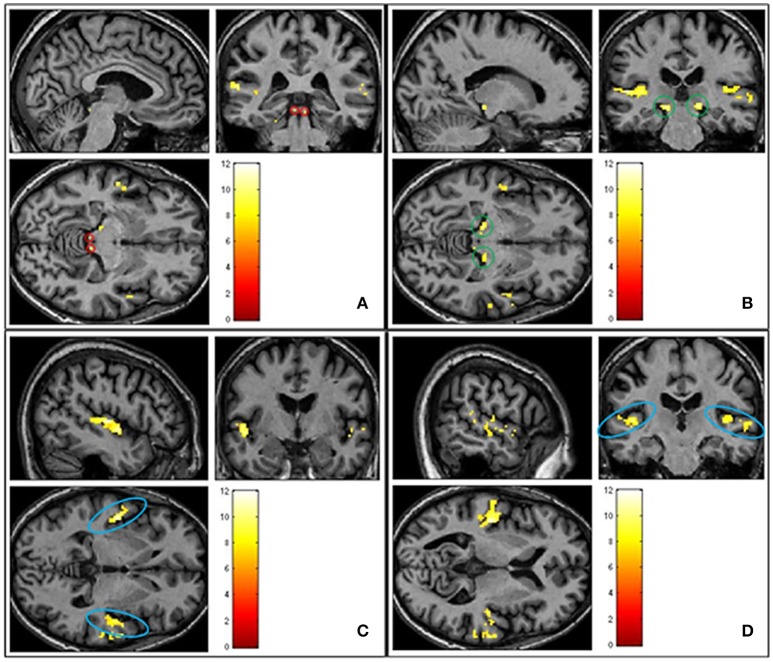
Shows group averaged (n = 23) activation of ascending auditory structures in response to all sound conditions (pleasant, neutral and unpleasant) > silence (p < 0.05 FWE corrected). (A) Inferior colliculus circled in red. (B) Medial geniculate body circled in green. (C) Primary auditory cortex circled in blue. (D) Primary auditory cortex circled in blue.